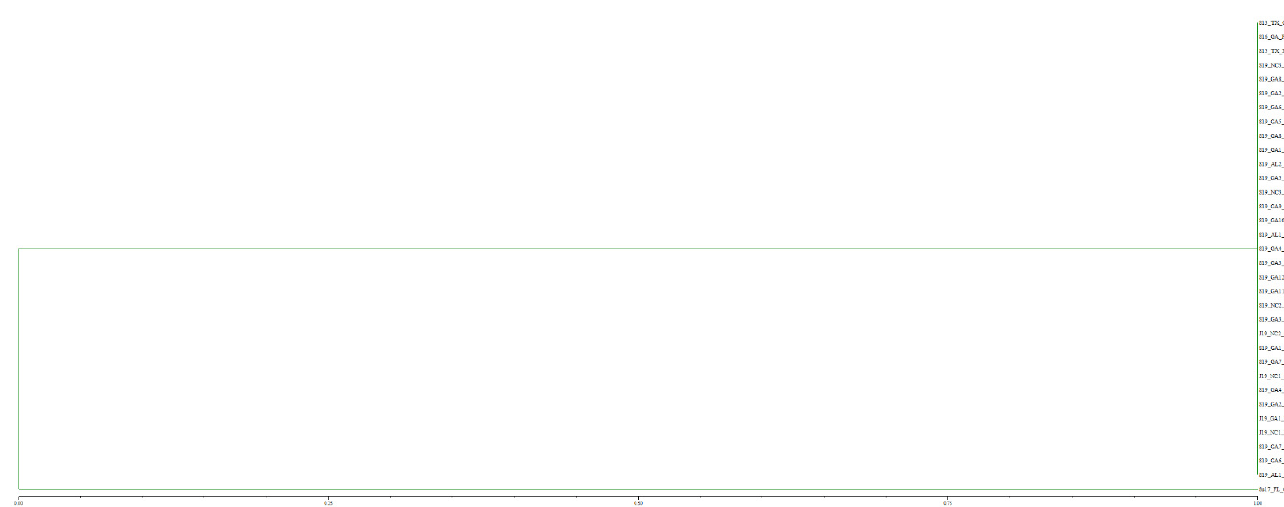
Figure 1. Unweighted pair group method with arithmetic mean dendrogram of 2019 Melanaphis spp. samples collected on sorghum and Johnsongrass from seven United States cities and genotyped using nine simple sequence repeat markers. All the Melanaphis samples collected in the United States in 2019 were found to be MLL-F ( Melanaphis sorghi ).